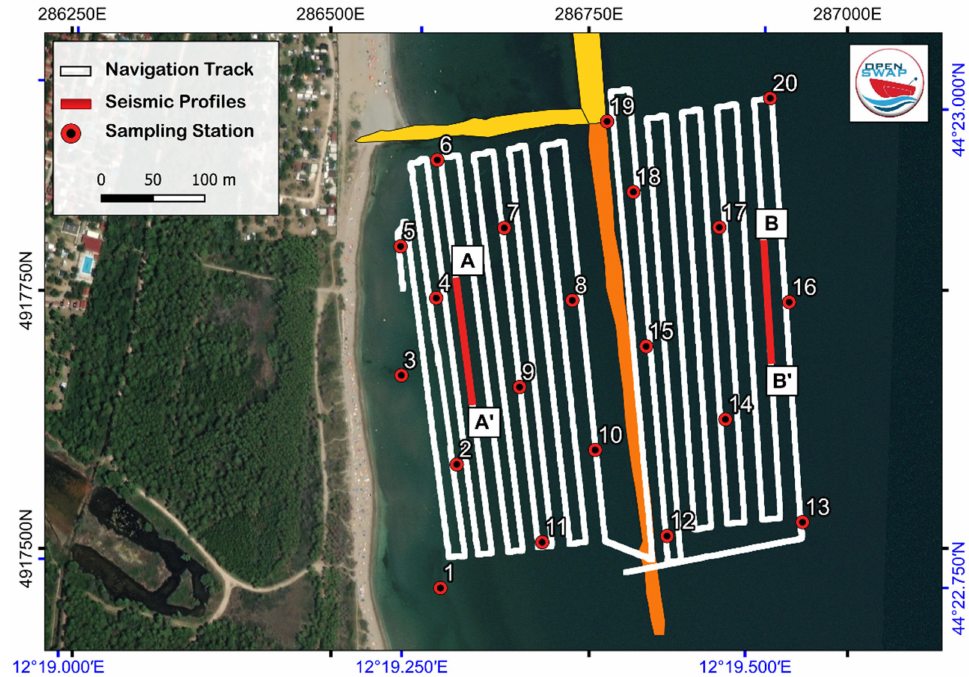
Figure 3. Acquisition line grid of echographic and seismic reflection lines implemented during the four surveys and the location of the seafloor sediment sampling stations (numbered red circles). A-A’ and B-B’ are location of seismic sections.